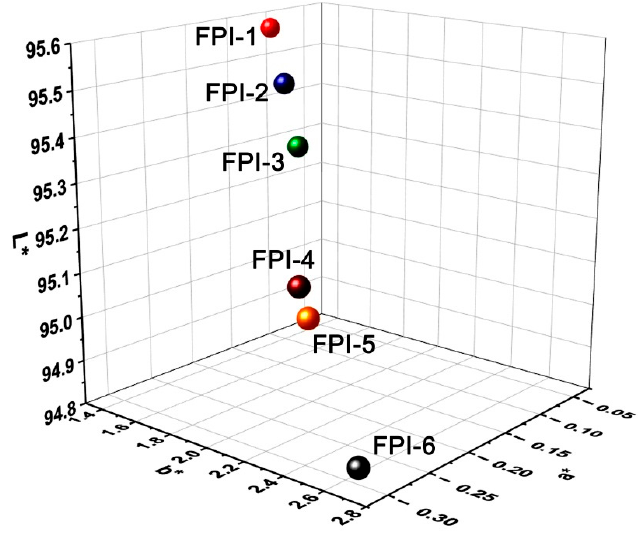
Figure 6. Three-dimensional CIE Lab color parameters of the FPI